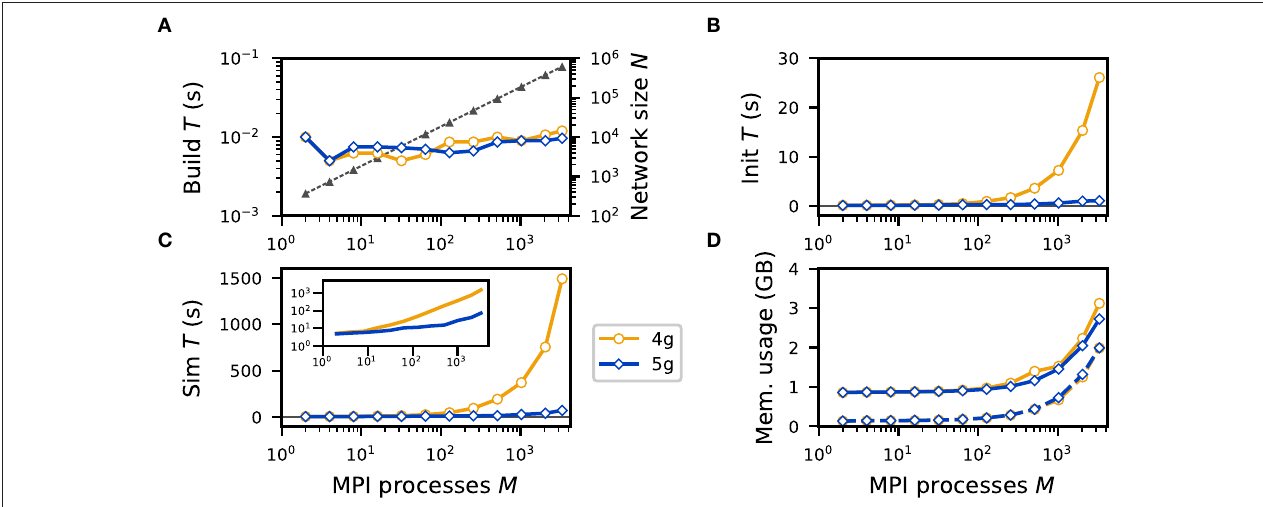
FIGURE 5 | Weak scaling of neuronal network simulation with gap junctions on a petascale computer. Runtime and memory usage per compute node for an increasing number of MPI processes in logarithmic representation M ∈ { 2 ; 4 ; 8 ; 16 ; 32 ; 64 ; 128 ; 256 ; 512 ; 1024 ; 2048 ; 3328 } with two MPI processes per compute node and T = 12 threads per MPI process on JURECA. Each compute node hosts N M = 185 neurons with K = 60 gap junctions per neuron. Network dynamics simulated for 0.5 s of biological time. Color code in all panels (legend): 4g (orange, open circles), 5g (blue, open diamonds). (A) Build time (logarithmic). Gray triangles and dashed line show the total network size N (right vertical axis, logarithmic). (B) Init time. (C) Sim time. Inset shows same data with logarithmic vertical axis. (D) Cumulative memory usage for a single MPI process after NEST startup (dashed curves) and after simulation (solid